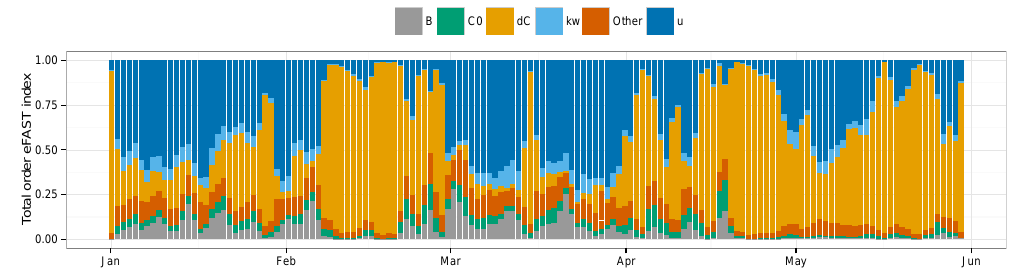
Figure 8. Warp eFAST total-order Sobol indices over time, indicating changing fractional contributions to uncertainty from each of the main